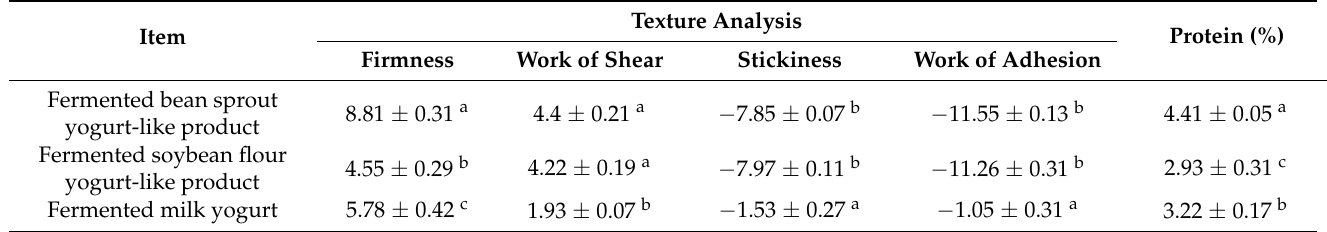
Table 4. Texture characteristics and protein content of fermented bean sprout yogurt-like product. a, b, and c in the table represent three products were significant difference in various textural